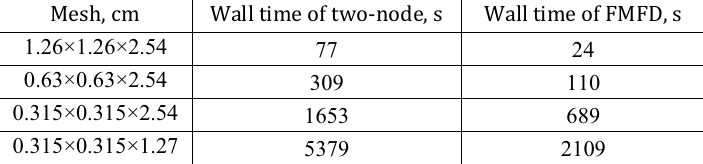
Table IV. Computing Time of Self-constructed